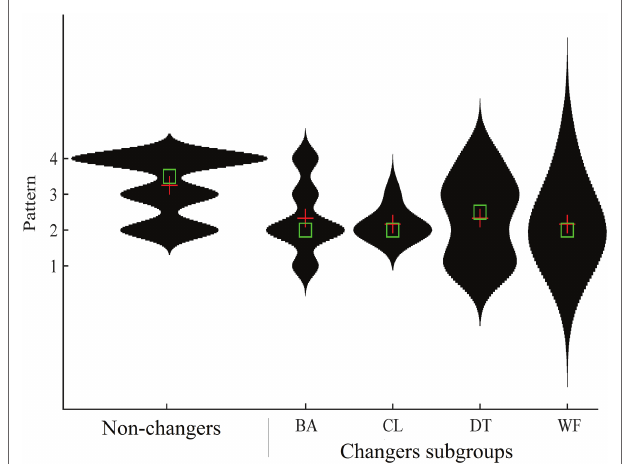
FIGURE 2 | Violin plots of TW pattern distributions for the Non-Changers and Changers subgroups. The green boxes denote the median and the red crosses denote the mean average. The wider the shape, the more frequently the TW patterns were expressed. The longer the shape, the larger the interquartile